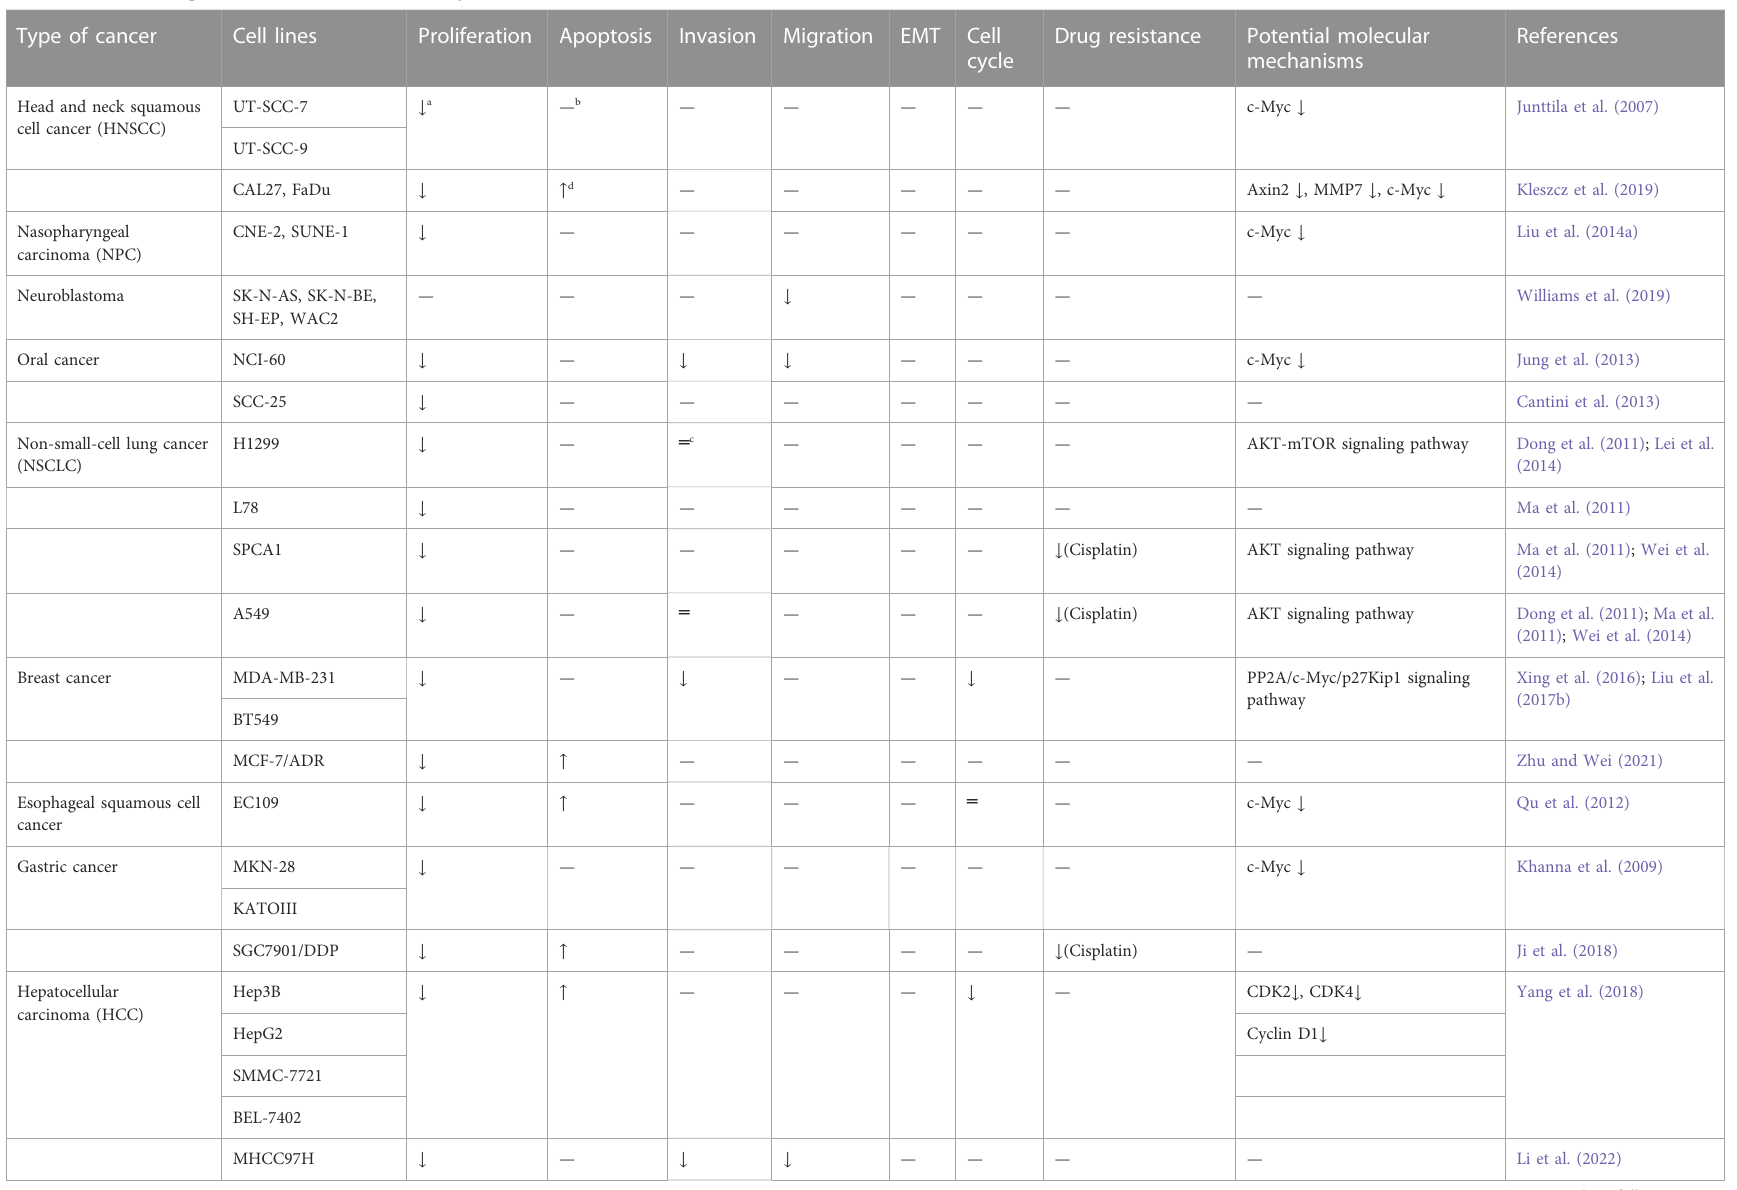
TABLE 1 siRNA downregulates CIP2A on tumor cells and potential molecular